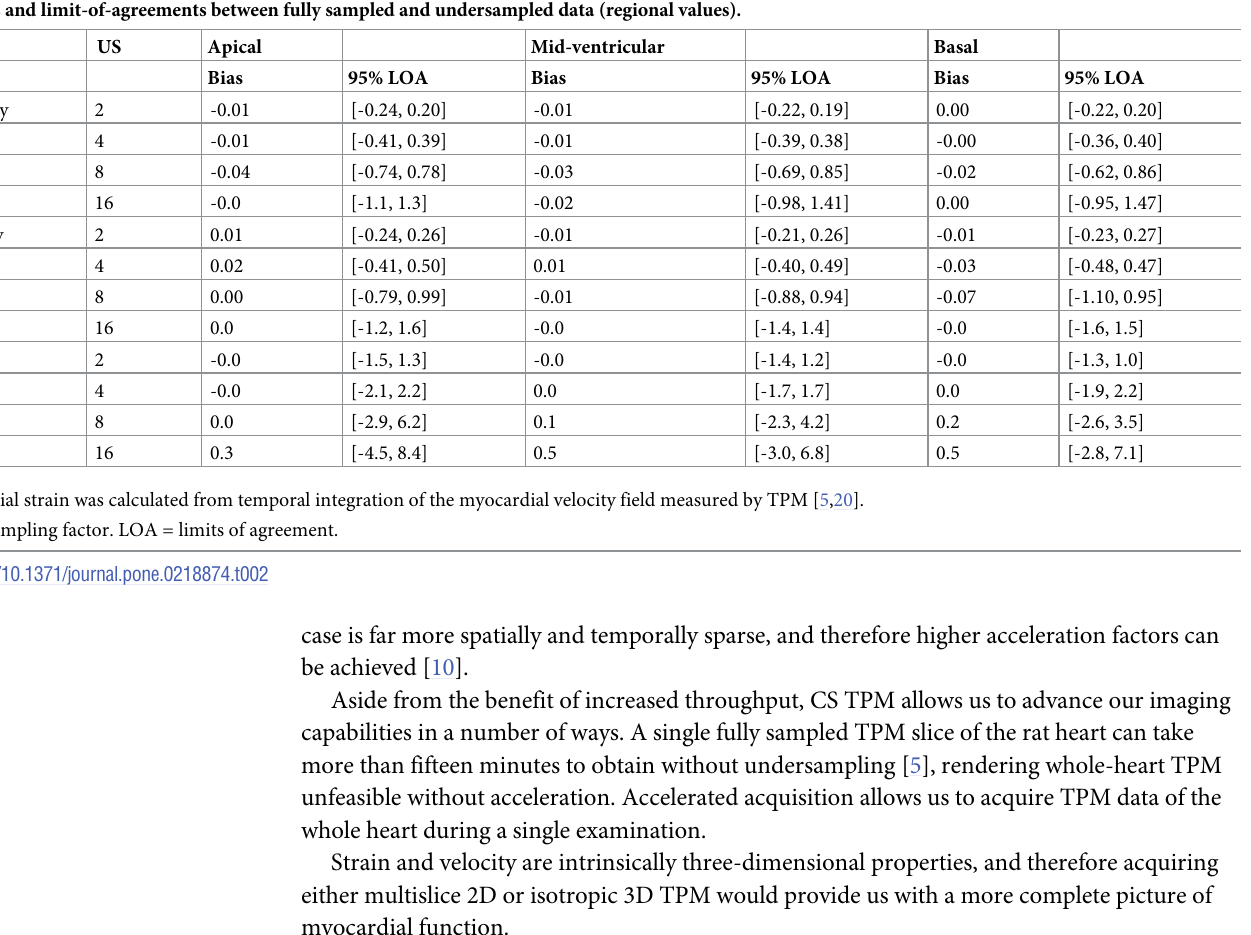
Table 2. Bias and limit-of-agreements between fully sampled and undersampled data (regional values).